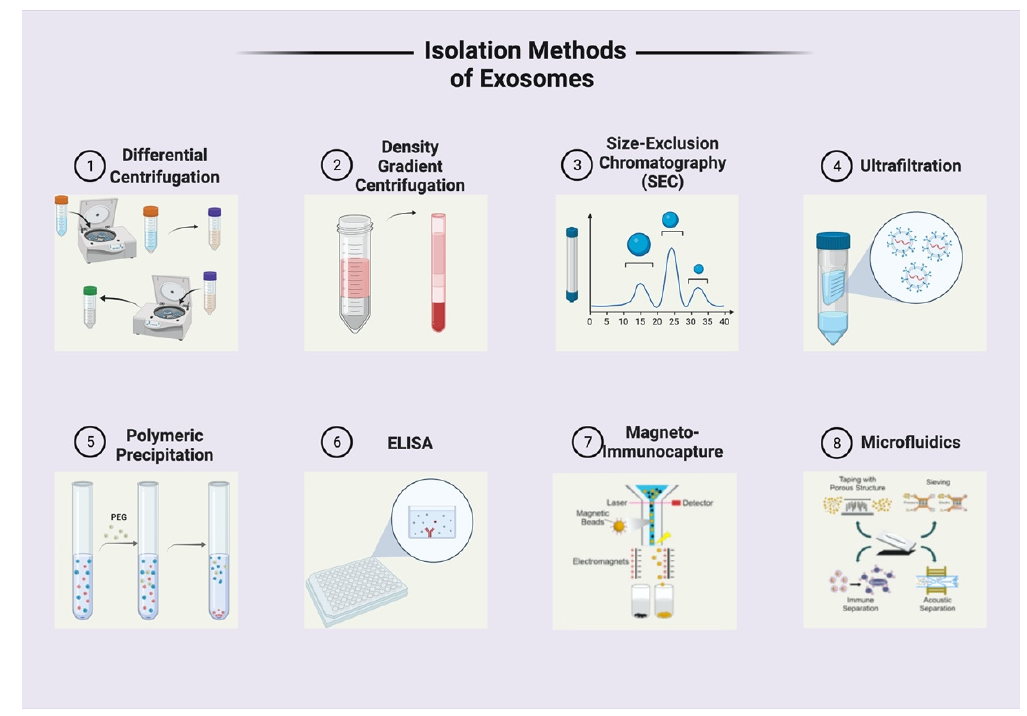
Figure 3. Exosome isolation techniques. Created with BioRender.com (accessed on 18 December 2021). Table 1. Summary of Exosome Isolation